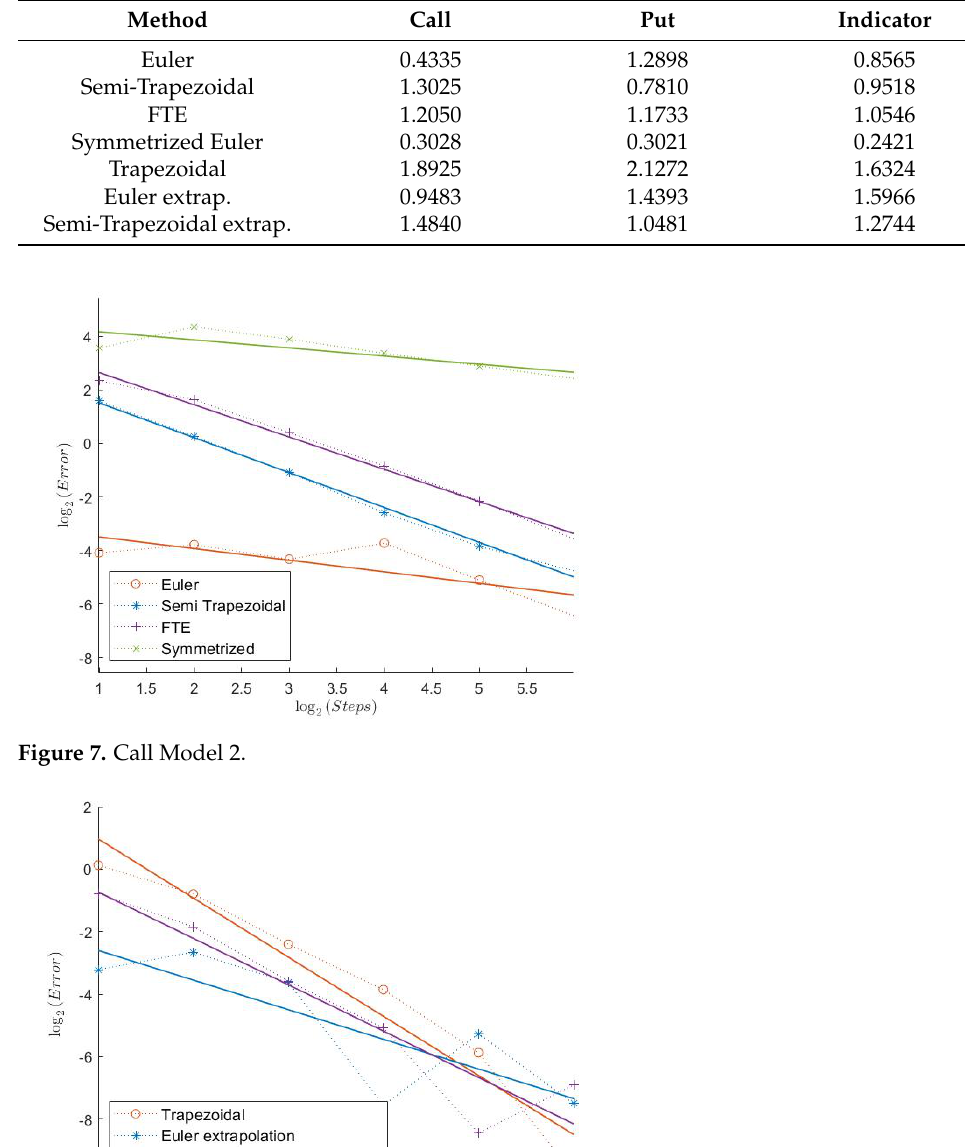
Table 2. Measured convergence rates Model 2.